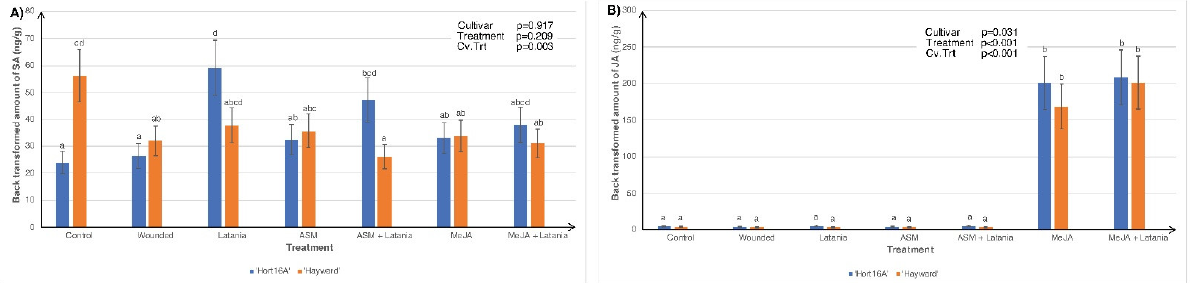
Figure 1. Phytohormone concentrations of ( A ) salicylic acid (SA) and ( B ) jasmonic acid (JA) in ‘Hort16A’ and ‘Hayward’ kiwifruit leaf tissue in 2016. Leaves were left unsprayed or were treated with 0.2 g/L Actigard™ (ASM) to induce the SA pathway or with 0.05% v / v methyl jasmonate (MeJA) to elicit the JA pathway. Latania scale crawlers (approximately 200/leaf) were applied seven days later, or leaf wounding (to imitate scale feeding) was achieved with a fine needle. Control plants were left untreated. Seven days after scale application, leaves were sampled for phytohormone measurements. There were five replicate plants per treatment. The Y-axis concentration scale is different for each phytohormone. Probability values from ANOVA are shown in the top right-hand corner of each bar chart, and each chart plots the cultivar × treatment interaction (Cv.Trt). Error bars give the standard errors, and different lettering (a, b, c, d) indicates statistically significant treatment differences, as shown by Fisher’s Least Significant Difference (LSD), p ≤ 0.05.